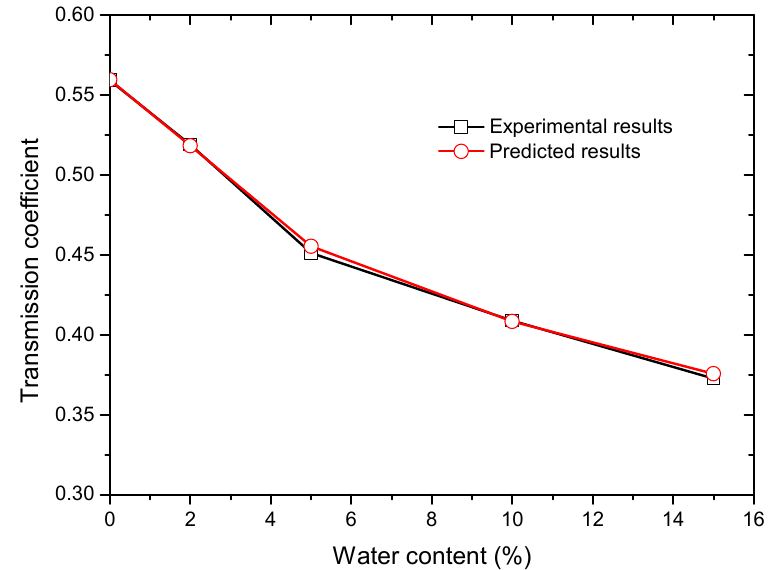
Figure 3. Variation of the transmission coefficient versus the water content by experiments (reproduced with permission from [12], Springer Wien, 2015) and predicted by our analytical model.